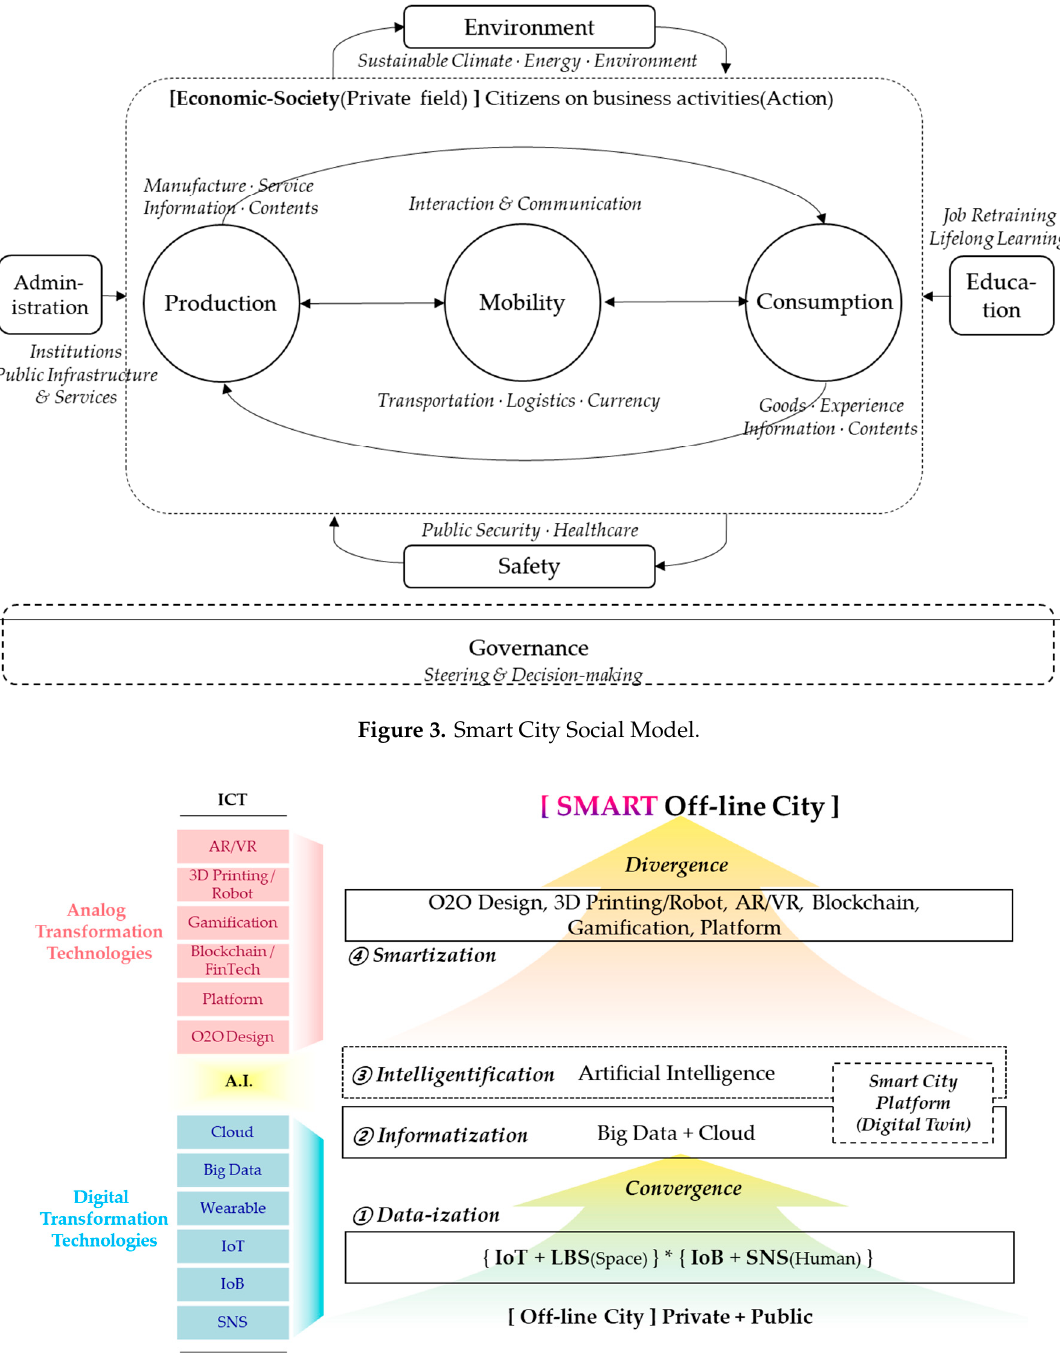
Figure 4. Smart City Technology Model.